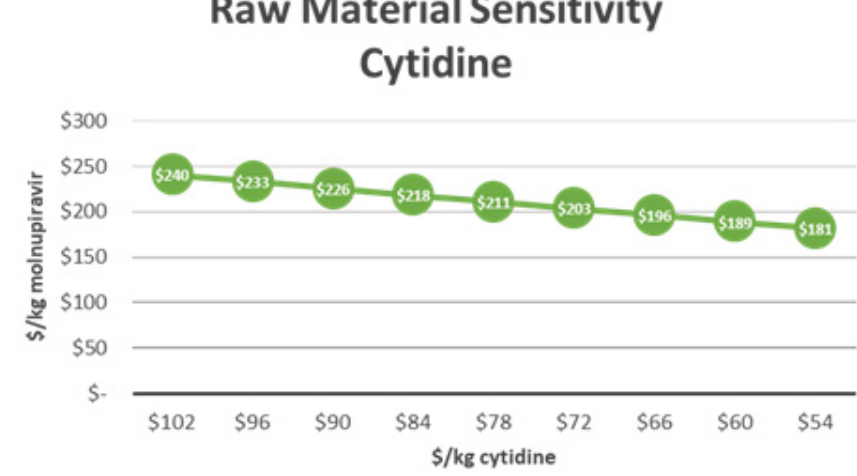
Figure 9. Biocatalytic Route (Manchester) raw material sensitivity for